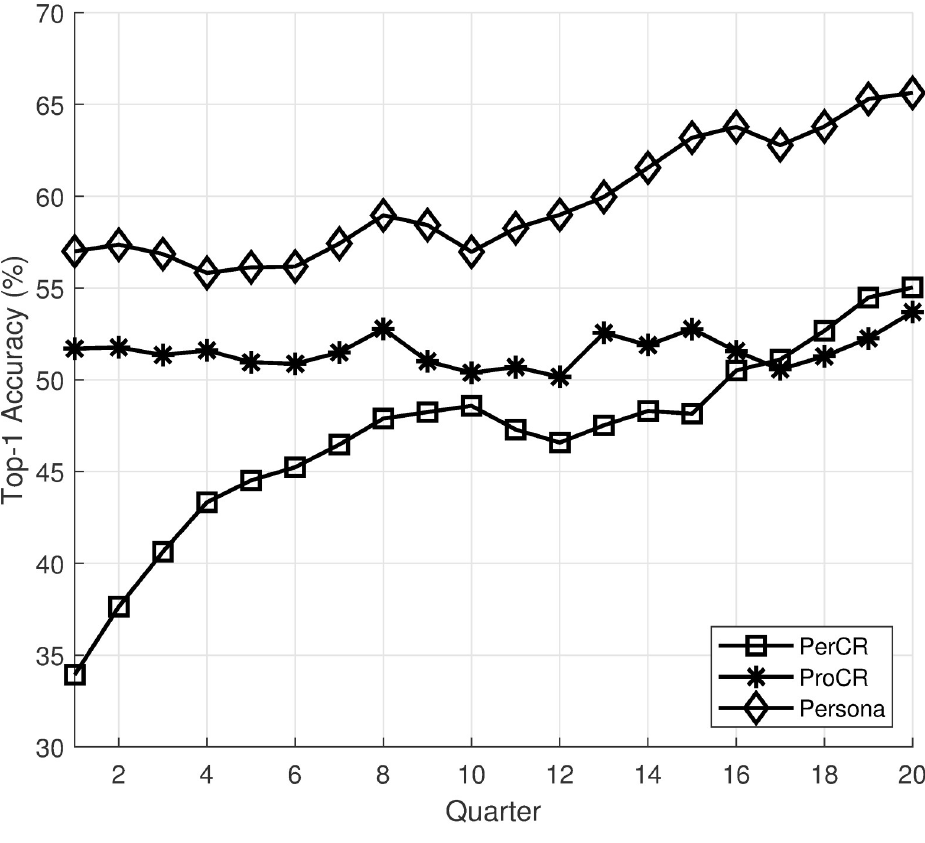
Fig 6. Top-1 accuracy over time of “Vladimir